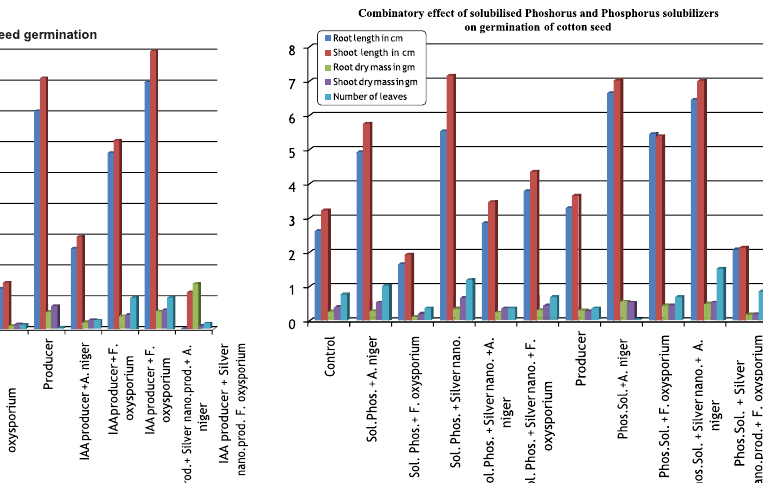
Fig. 4. Effect of phosphate solubilization on seed germination